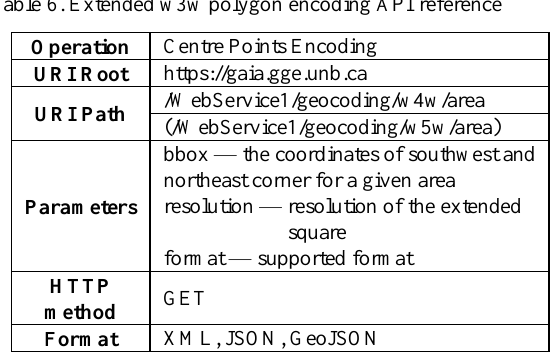
Table 6. Extended w3w polygon encoding API reference